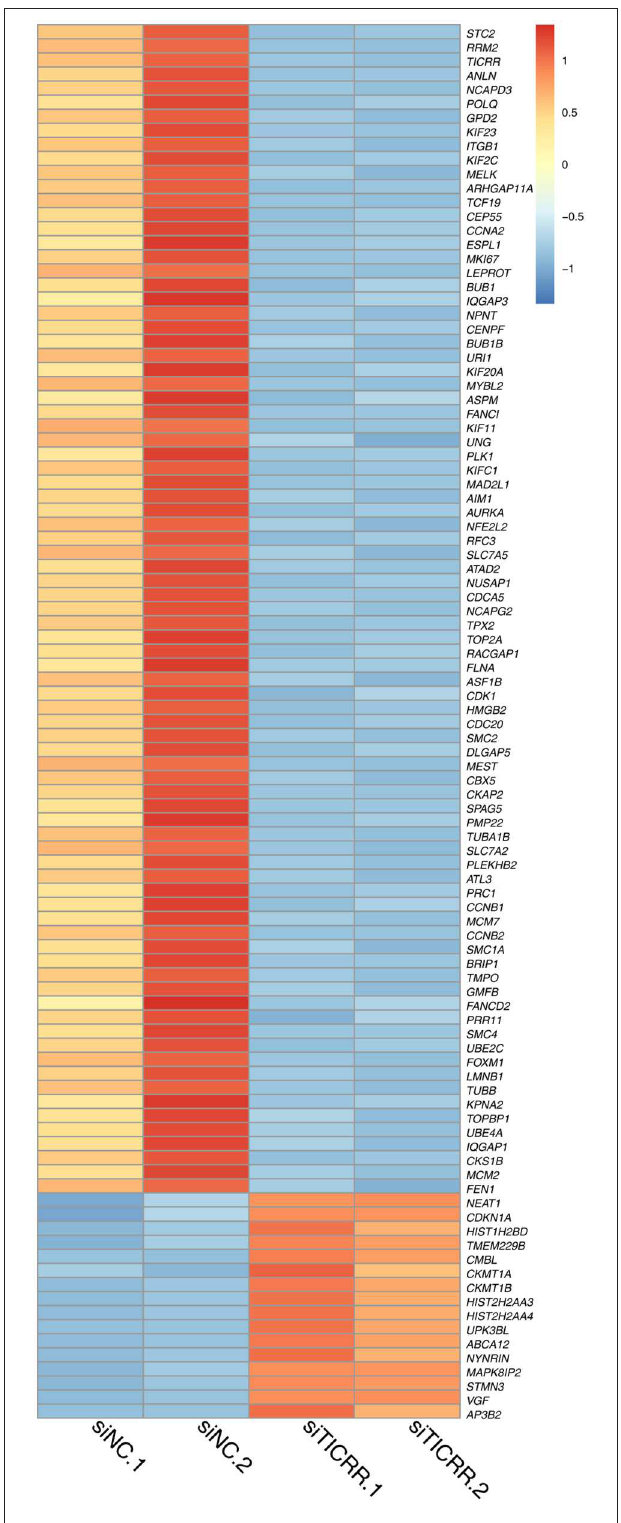
FIGURE 6 | Heatmap of 100 DEGs obtained from two TICRR -knockdown samples (siTICRR.1 and siTICRR.2) and two control samples (siNC.1 and siNC.2). Probability of gene expression difference > 0.8 is considered differentially